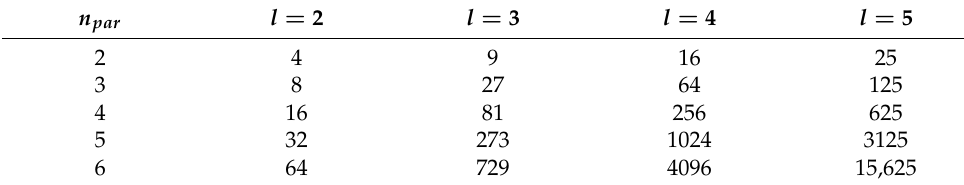
Table 1. Total number of subspaces for different numbers of parameters and levels. n